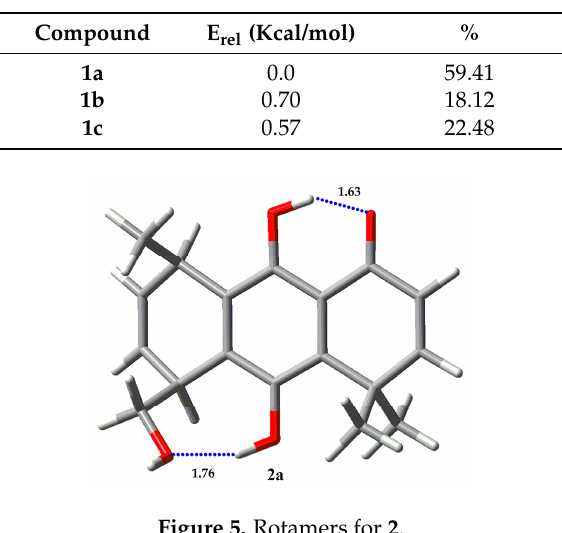
Figure 4. Rotamers for 1 . Table 1. Boltzmann population for rotamers of 1 .